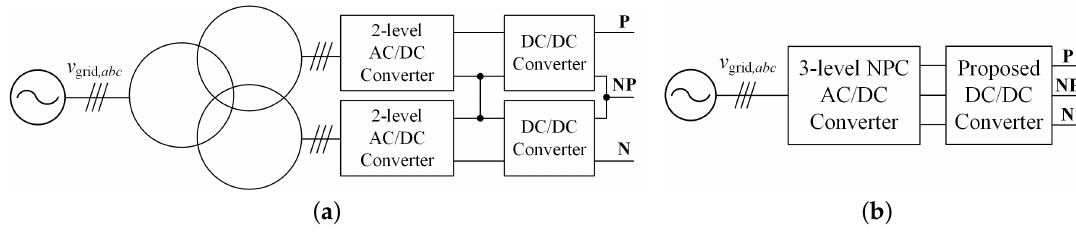
Figure 10. Composed of AC/DC converter system for the bipolar LVDC distribution: ( a ) 2-level AC/DC converter; ( b ) 3-level AC/DC